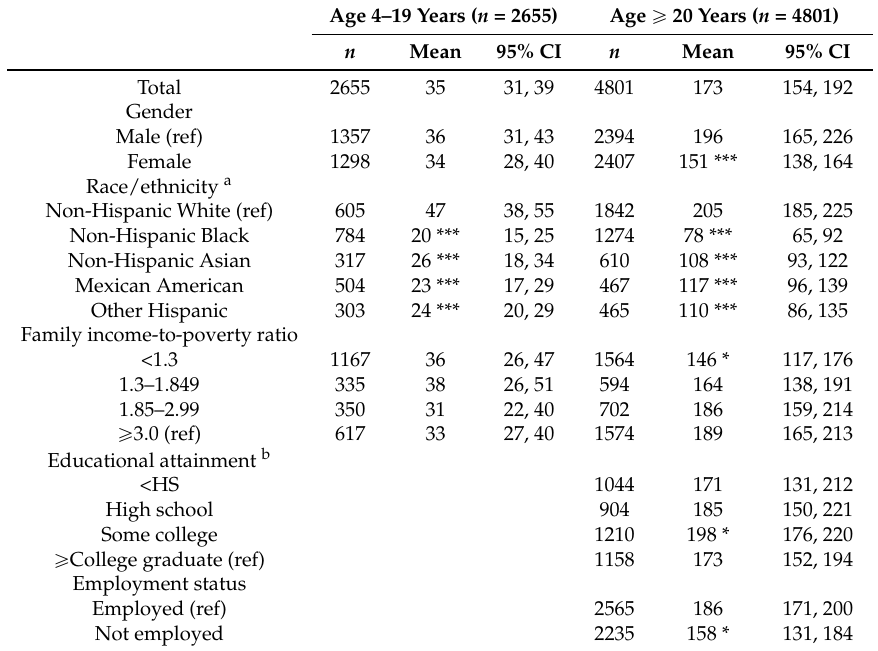
Table 1. Average caffeine consumption by race/ethnicity, family income, educational attainment and employment status among children/adolescents and adults,